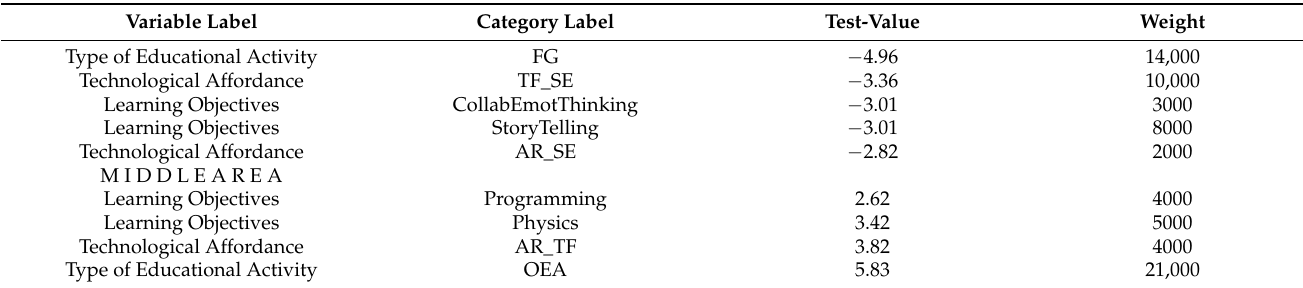
Table 4. Printout on factor 1 by the active